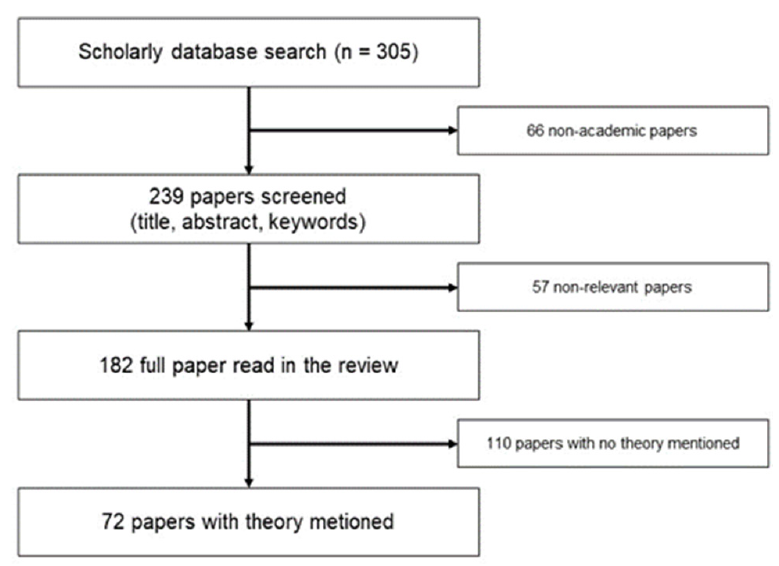
Figure 1. Paper selection through PRISMA’s procedure.